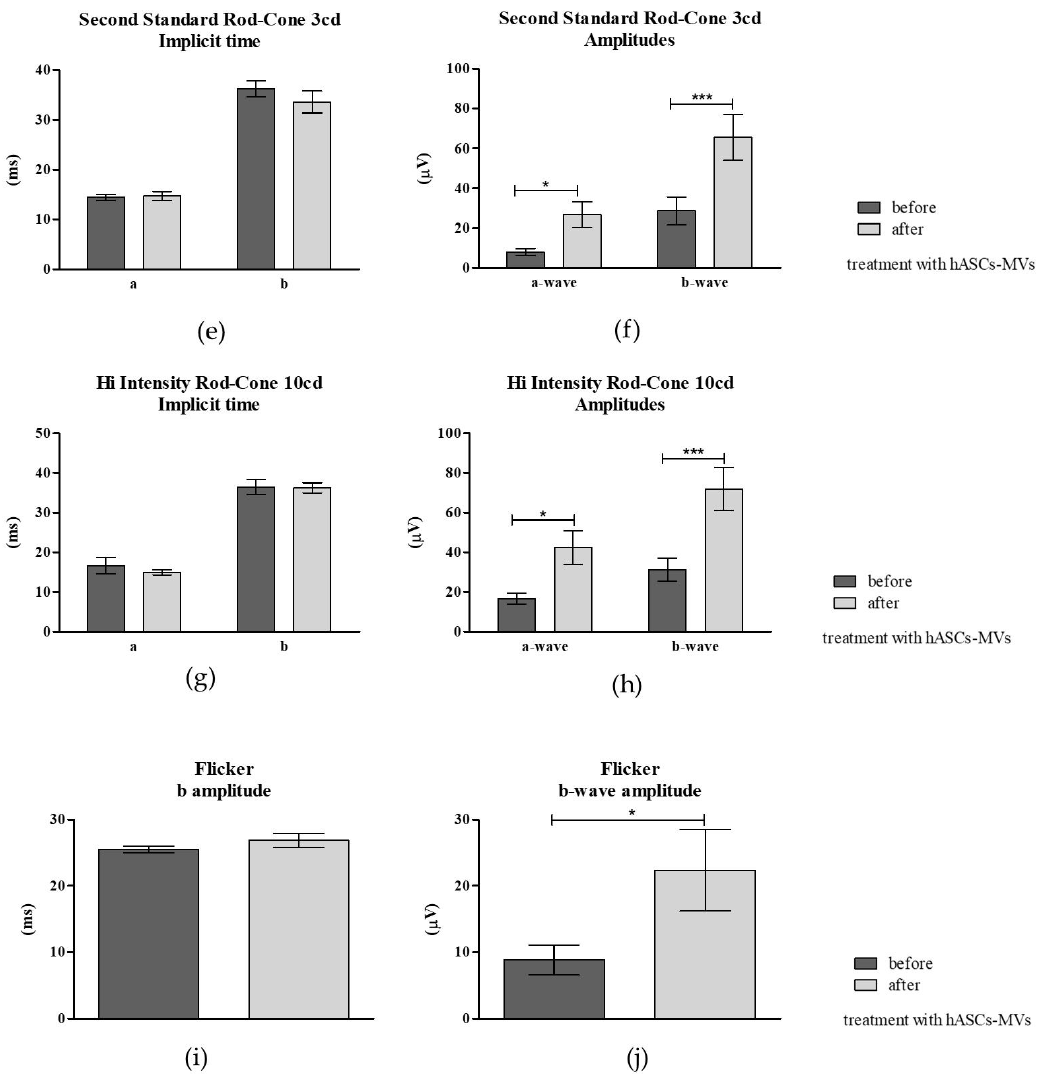
Figure 9. The results of ERG measurements. Mean values of ERG recordings obtained for nine dogs. The analysis included comparison of implicit times as well as a- and b-wave amplitudes before and after hASC-MVs implantation. The analysis was based on determination of following parameters: Standard Rod-Cone w / 1 flash using implicit time ( a ) and amplitudes ( b ); First Standard Rod-Cone 3cd with implicit time ( c ) and amplitudes ( d ); Second Standard Rod-Cone 3cd with implicit time ( e ) and amplitudes ( f ); Hi Intensity Rod-Cone 10cd with implicit time ( g ) and amplitudes ( h ); Flicker b amplitude implicit time ( i ) and Flicker b-wave amplitude ( j ). Statistically significant di ff erences are indicated with asterisks (*). The statistically significant di ff erences were determined at p ≤ 0.05 (*) and p ≤ 0.001 (***). The results are expressed as mean ±